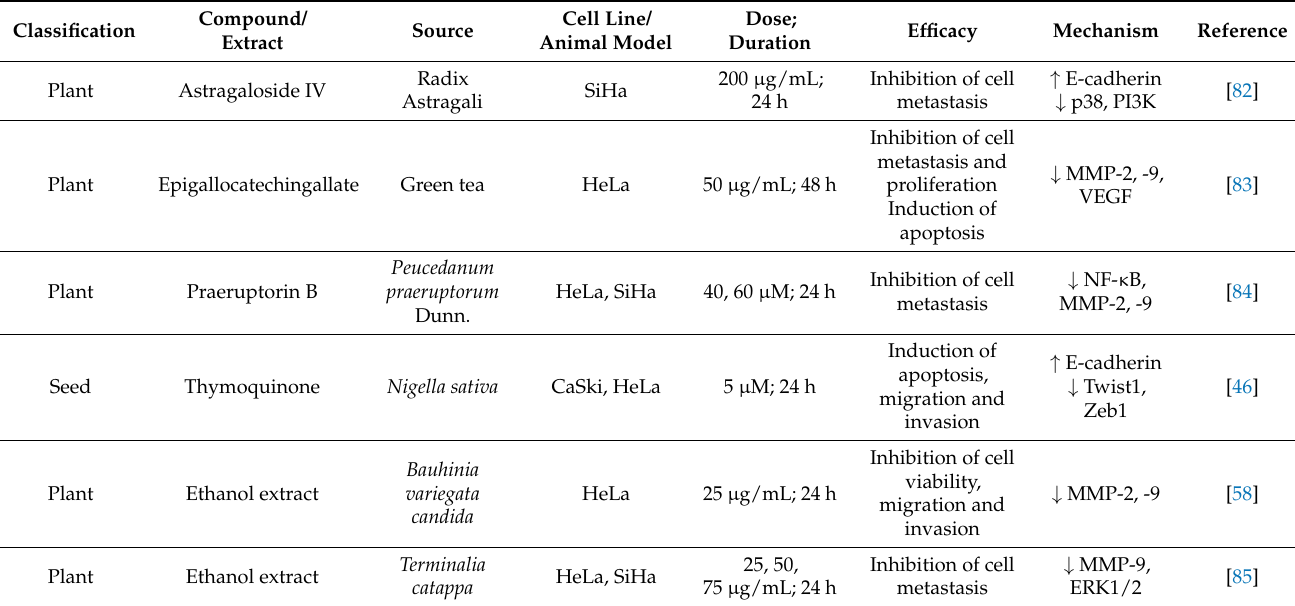
Table 4. Metastasis inhibiting natural products.